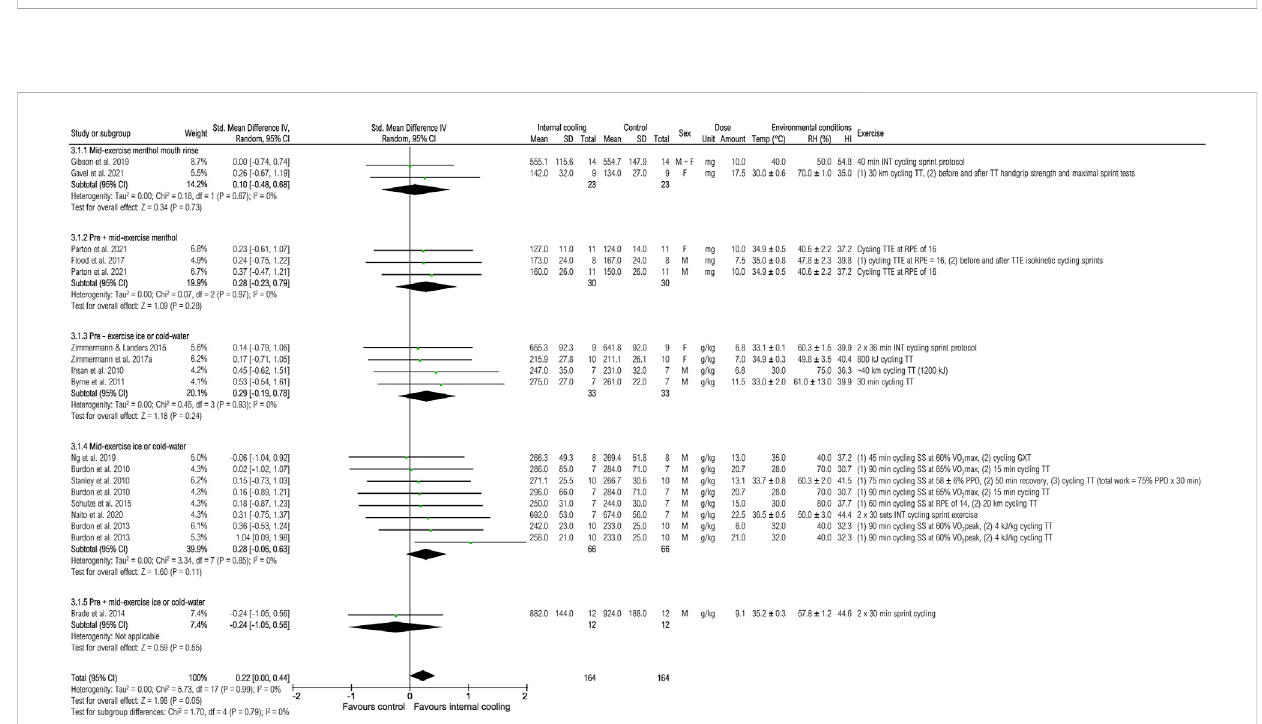
FIGURE 4 Meta-analysisof standardized meandifference inmeanpower output[W]with 95% CIbetweeninternal cooling andcontrol.F,female;GXT,graded exercise test; HI, heat index; INT, intermittent exercise; M, male; PPO, peak power output; RH, relative humidity; RPE, rate of perceived exertion; SS, steady-state exercise; Temp, ambient temperature; TT, time trial; TTE, time to exhaustion; VO 2 max, maximum oxygen consumption; VO 2 peak, peak oxygen